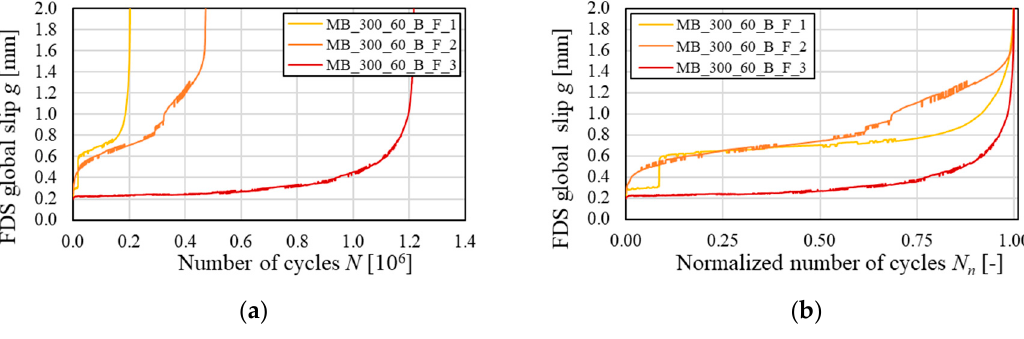
Figure 6. FDS global slip vs. ( a ) number of cycles and ( b ) normalized number of cycles for specimen subjected to fatigue test.